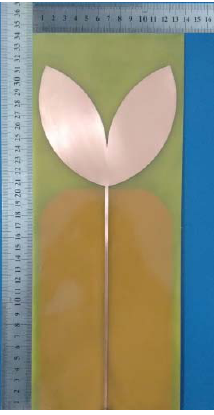
Figure 4. Manufactured bio ‐ inspired antenna.